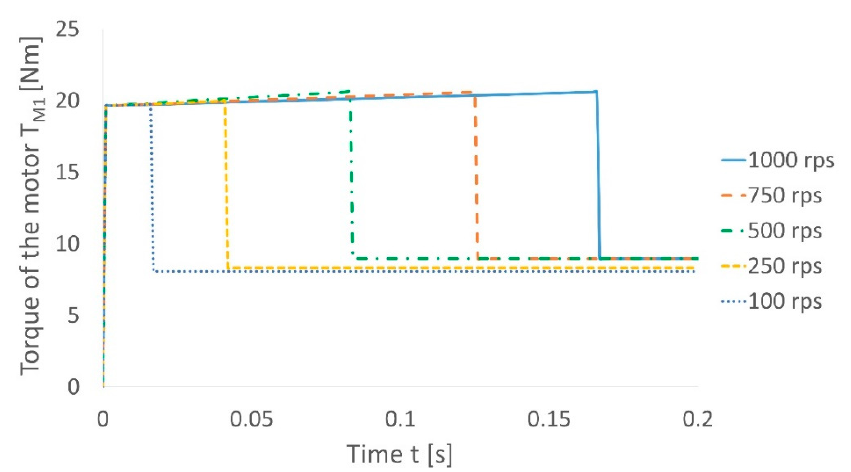
Figure 12. Characteristic curve for the perforating head drive motor torque for rotational acceleration ε = 100 rev/s 2 and various maximum rotational speed ω and assuming uncut strand resistance force of F R = 50 N.